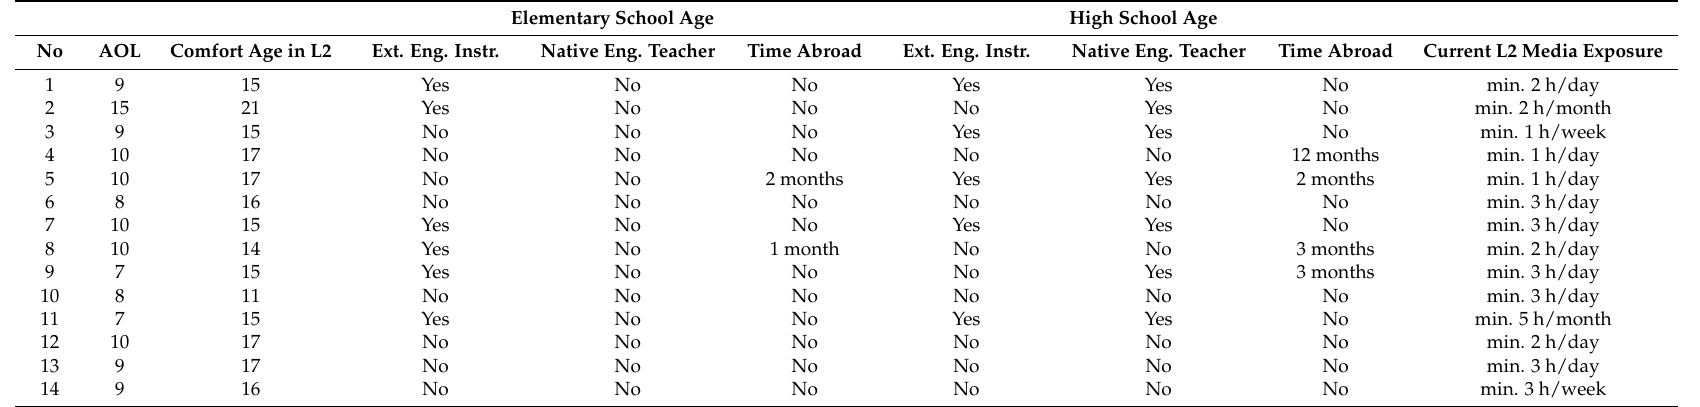
Table A1. Language experience questionnaire: Learner number (No), age at the onset of learning (AOL); age at which learner felt comfortable in L2; learning experience at elementary school age and high school age (extended English language instruction (Ext. Eng. Instr.), contact with a native English teacher, time spent in an English-speaking country); current minimum estimated exposure to English in